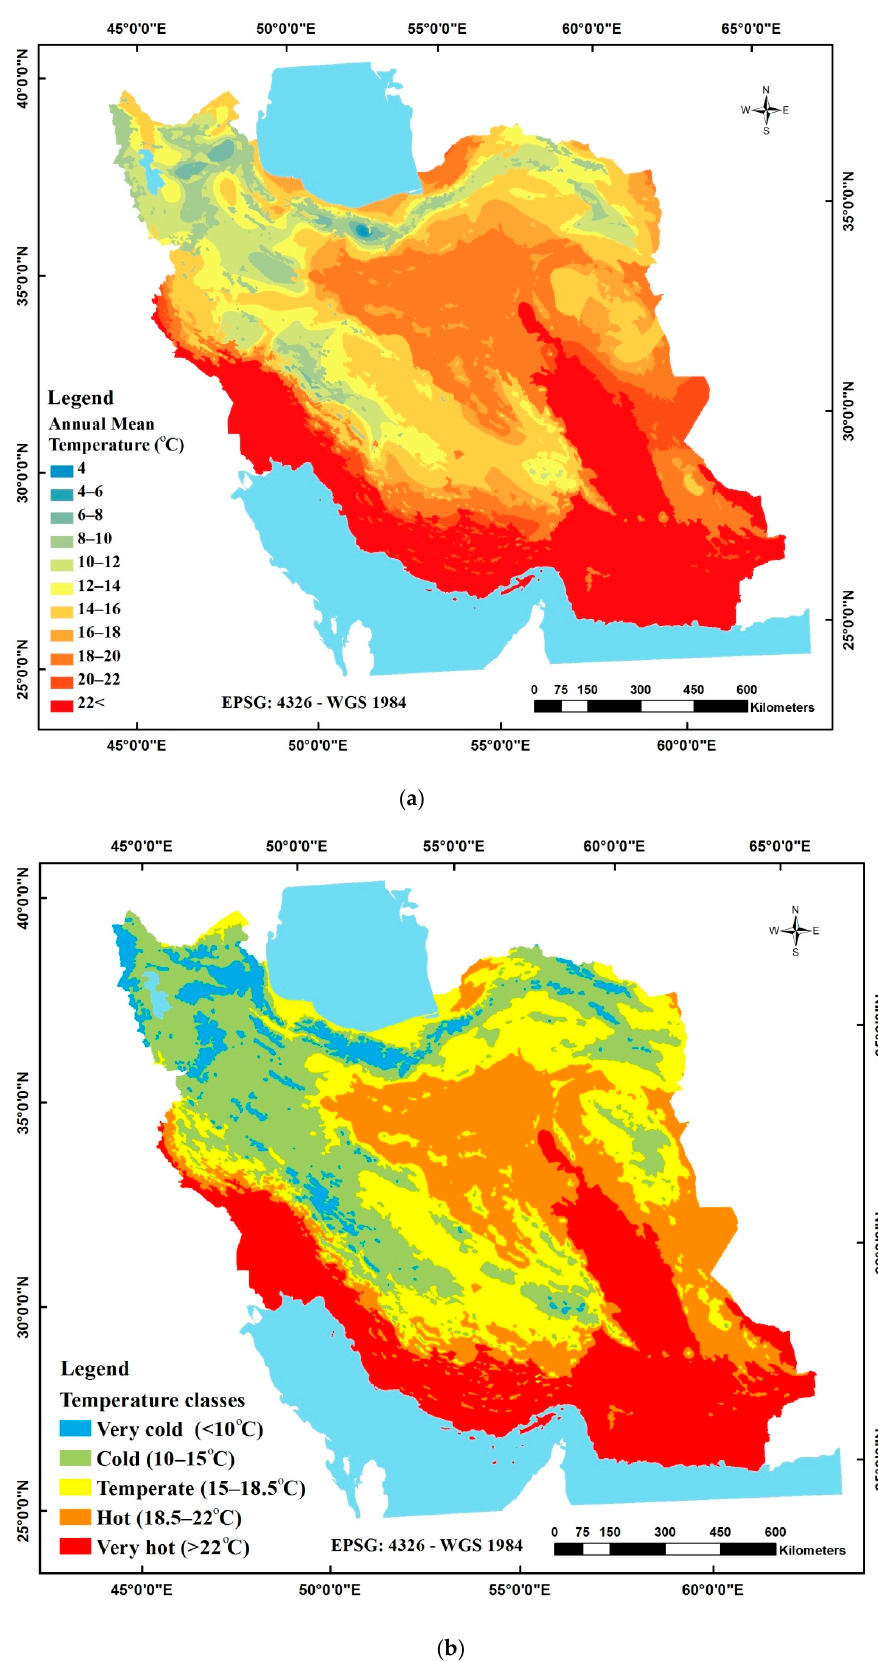
Figure 4. Spatial variability of the annual mean temperature ( a ) and its qualitative classes ( b ). The evaluation of the spatial distribution of the annual average precipitation showed that the higher precipitation values are concentrated on the Caspian coastlines in the north and western hillsides of the middle of the Zagros, followed by other regions along the Alborz and the Zagros hillsides. The central and southeastern areas are among the regions with the lowest precipitation in Iran. A low-precipitation core is observed in the central deserts of Iran, with three high-precipitation cores in the Zagros (Figure 5a).